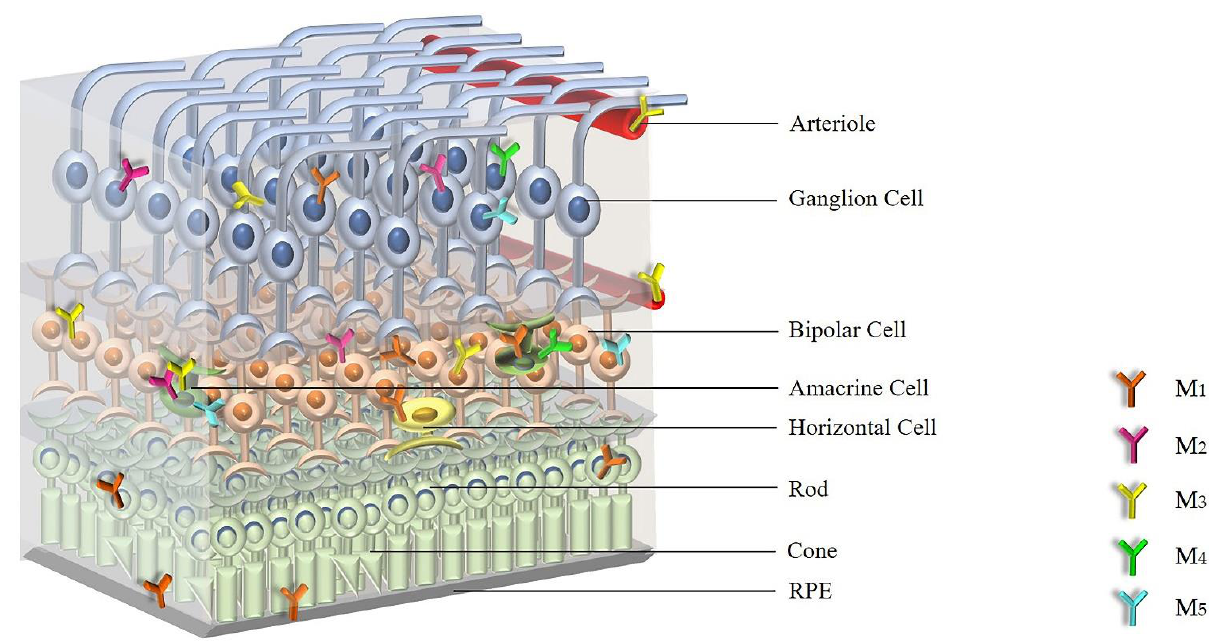
Figure 1. The distribution of individual mAChR subtypes in the retina. Abbreviations: mAChRs: muscarinic acetylcholine receptors; RPE: retinal pigment epithelium; M 1 : M 1 muscarinic acetylcholine receptor; M 2 : M 2 muscarinic acetylcholine receptor; M 3 : M 3 muscarinic acetylcholine receptor; M 4 : M 4 muscarinic acetylcholine receptor; M 5 : M 5 muscarinic acetylcholine receptor.